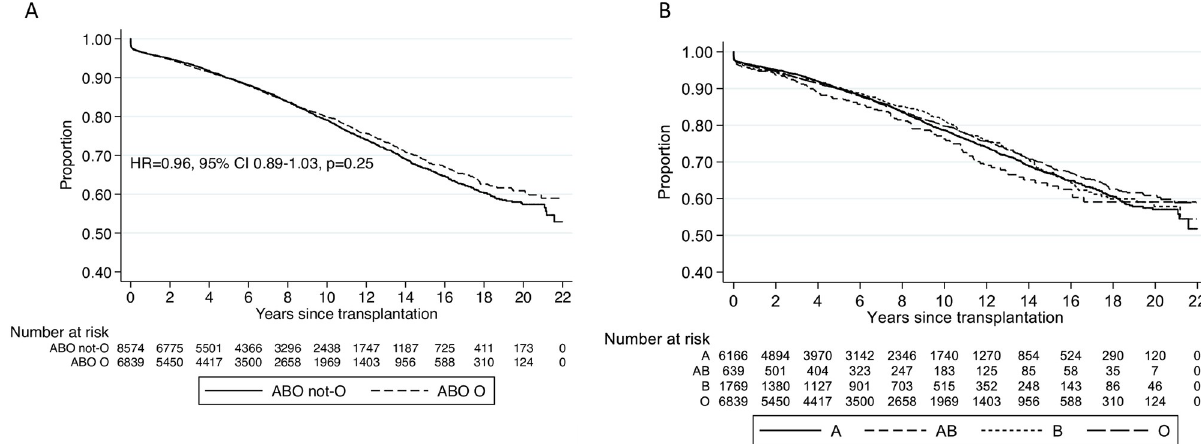
Fig 3. Kaplan Meier survival curve for death censored graft survival by recipient ABO blood group. (A) Recipient blood group O vs. non-blood group O. (B) All recipient blood groups.